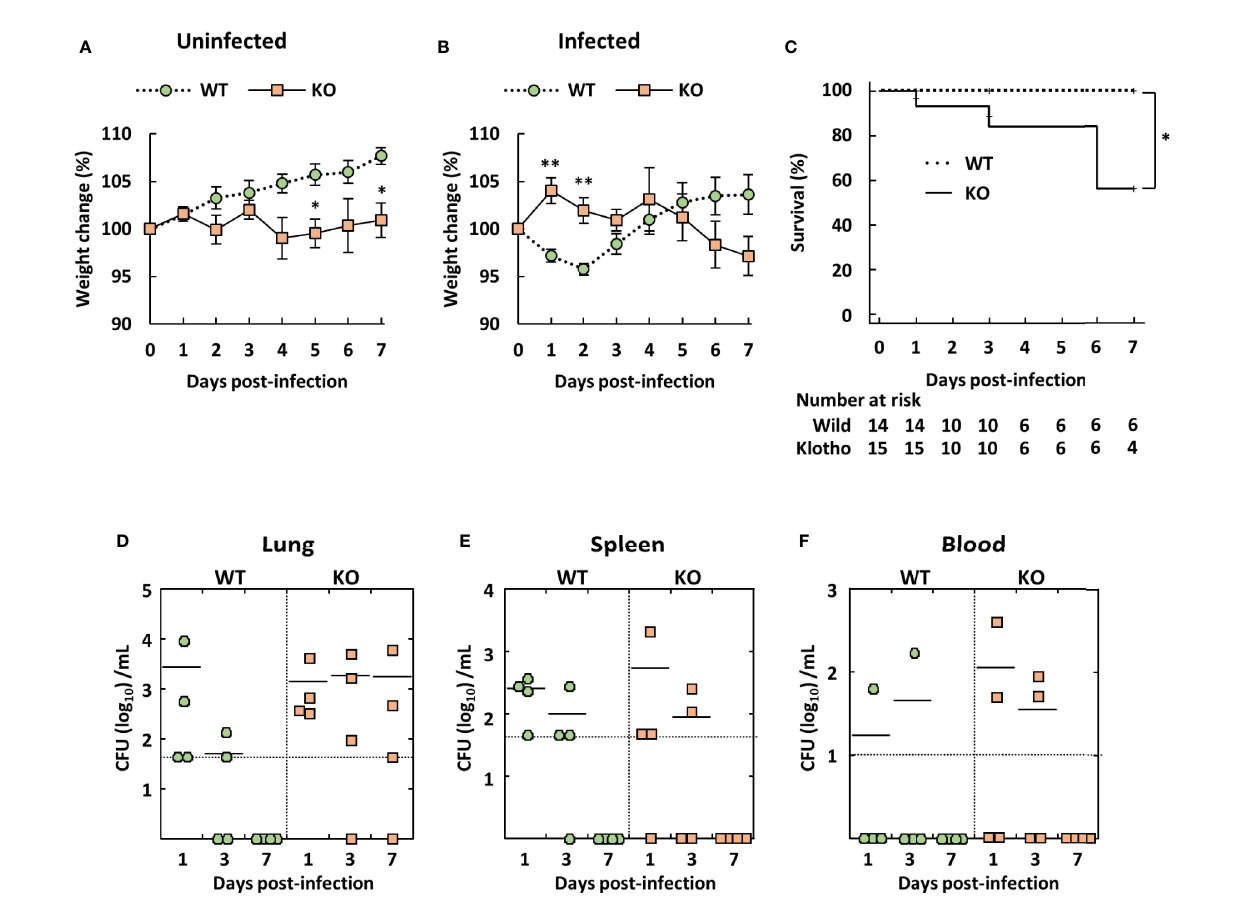
FIGURE 1 | Weight change, survival rate, and bacterial burden of klotho wildtype (WT) and knockout (KO) mice infected with Acinetobacter baumannii . A. baumannii ATCC 19606 (10 8 CFU/mouse) was inoculated intravenously into 6-week-old klotho WT and KO mice. (A) Summarized results show weight changes of uninfected klotho WT and KO mice, and represent the mean ± SEM (WT, n = 5; KO, n = 5). (B) Summarized results show weight changes of klotho WT and KO mice after infection with A. baumannii , and represent the mean ± SEM (WT, n = 14; KO, n = 15). These data are compiled from three independent experiments. Asterisks indicate statistically signi fi cant differences (** P < 0.01; * P < 0.05, klotho WT mice vs. klotho KO mice; Student ’ s t -test). (C) Survival curves of klotho WT and KO mice after infection with A. baumannii are shown (WT, n = 14; KO, n = 15). These data are compiled from three independent experiments. Comparison of survival curves with log rank test yielded statistical signi fi cance (* P = 0.04). Summarized results show (D) bacterial count in the lungs, (E) spleen, and (F) blood of klotho WT ( n = 12) and KO ( n = 12) mice after infection with A. baumannii . These data are compiled from two independent experiments. There are no signi fi cant differences between klotho WT and KO mice. Each symbol represents one mouse. The mean value is shown as a horizontal solid